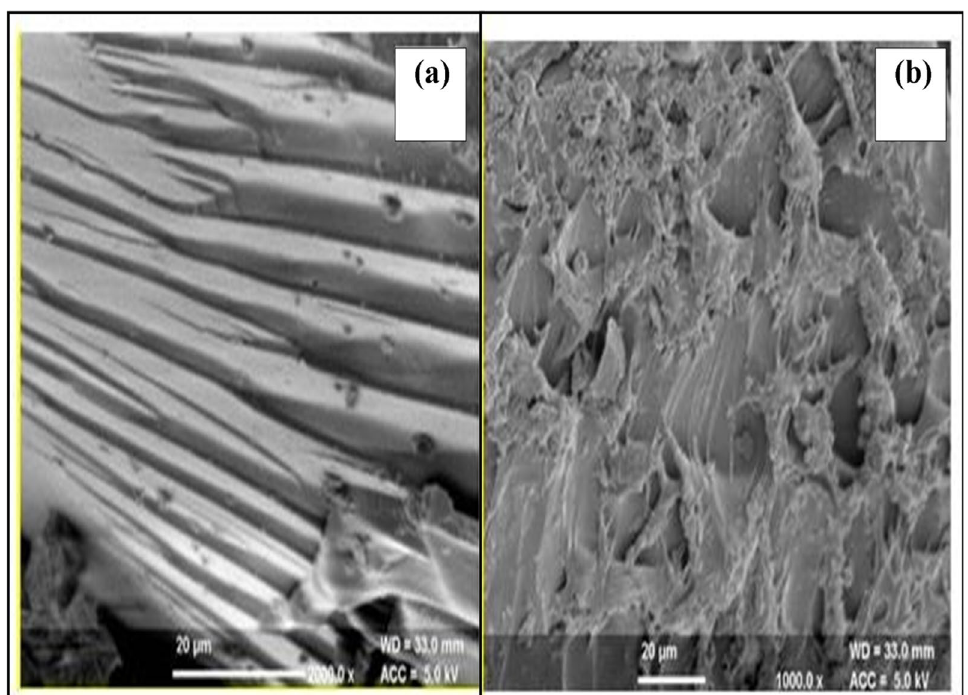
Fig. 2 a, b SEMs of a Aloe vera and b